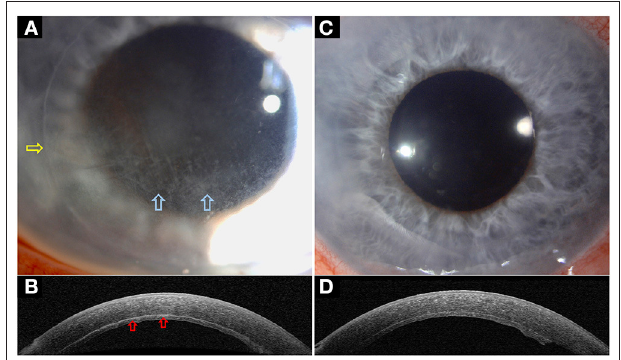
FIGURE 2 | A case of interface infectious keratitis (IIK) following Descemet stripping automated endothelial keratoplasty (DSAEK). (A,B) Slit-lamp photography demonstrating an inflamed right eye with diffused stromal haze in a crisscross pattern at the graft-host interface (blue arrows), consistent with a diagnosis of IIK. The edge of the DSAEK graft is visible (yellow arrow). The hyper-reflective changes at the graft-host interface (red arrows) are clearly delineated on anterior segment optical coherence tomography (AS-OCT) highlighting the value of AS-OCT in facilitating the assessment of infectious, keratitis. (C,D) Slit-lamp photography demonstrating a complete resolution of the IIK following intensive topical anti-fungal treatment, evidenced by the disappearance of the stromal haze on slit-lamp photograph and the hyper-reflective changes at the graft-host interface on AS-OCT. (A) is reproduced from Ting et al. (22) with